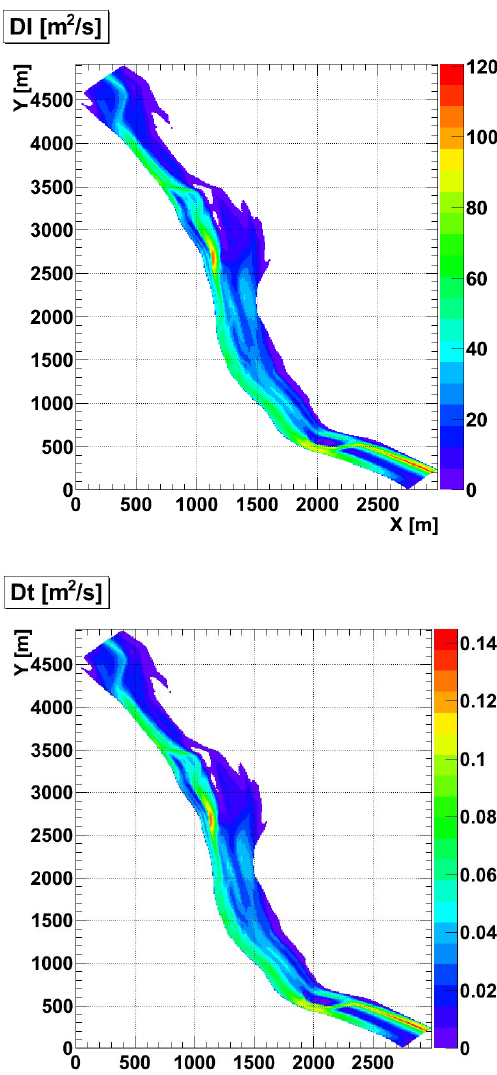
Fig. 8. The longitudinal D L and transverse D T dispersion coeffi- cients for the considered reach of the Vistula River, computed for the local values of river depth and bed shear